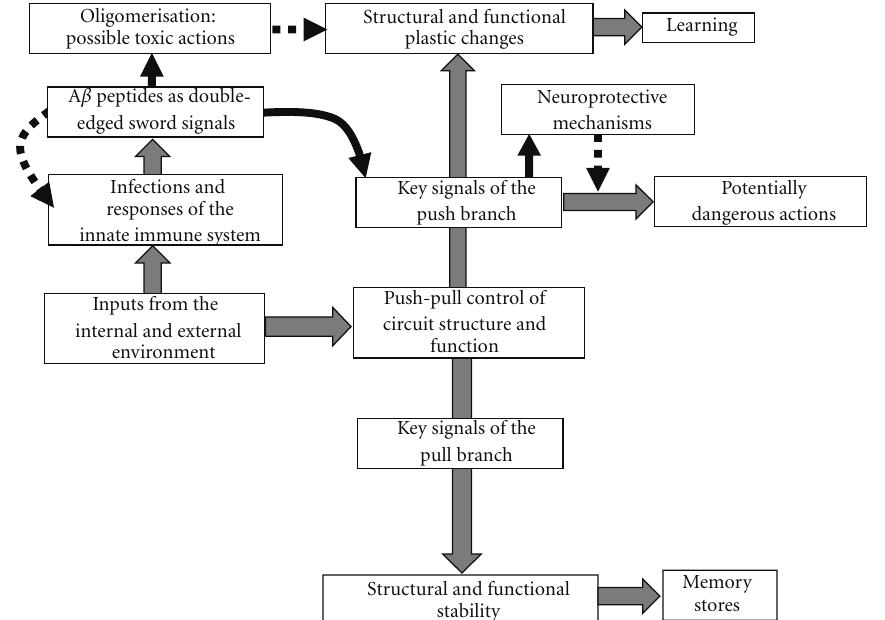
Figure 1: Schematic representation of the “Push and Pull Control” of structural and functional plasticity of neuronal circuits and how this control is related to learning processes (plastic changes of the circuits) and maintenance of the memory traces (stability of the circuits). The possible actions of A β peptides as double-edged sword signals are indicated. Broken arrows indicate reduction or